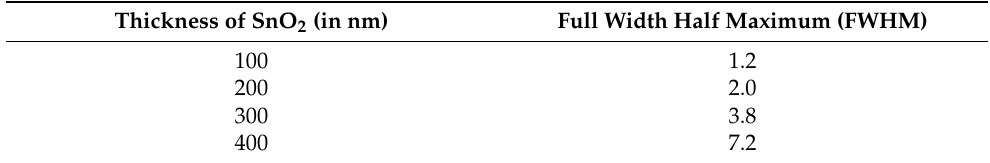
Table 1. Values of FWHM with thickness of SnO 2 thin film.